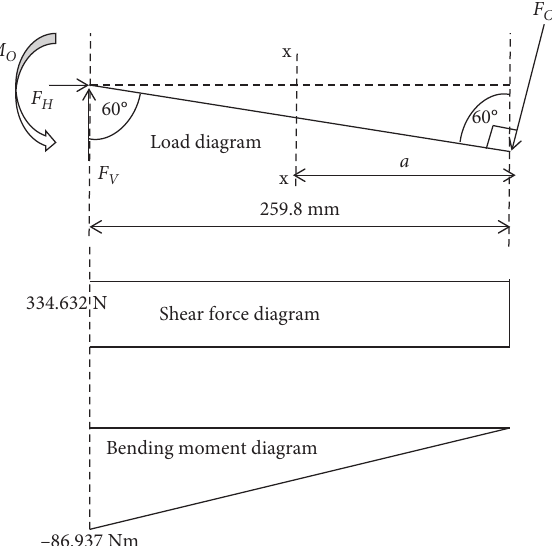
Figure 8: Load, shear force, and bending moment diagrams of the handle.